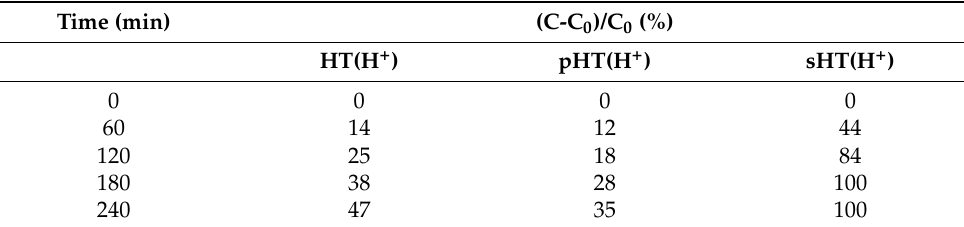
Table 2. Removal (%) of MO molecules versus irradiation time for the investigated samples. Time (min)